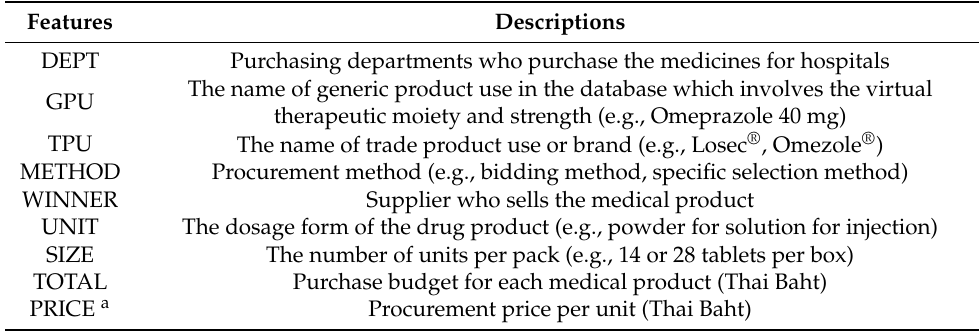
Table 1. The features and the definitions of the dataset in our